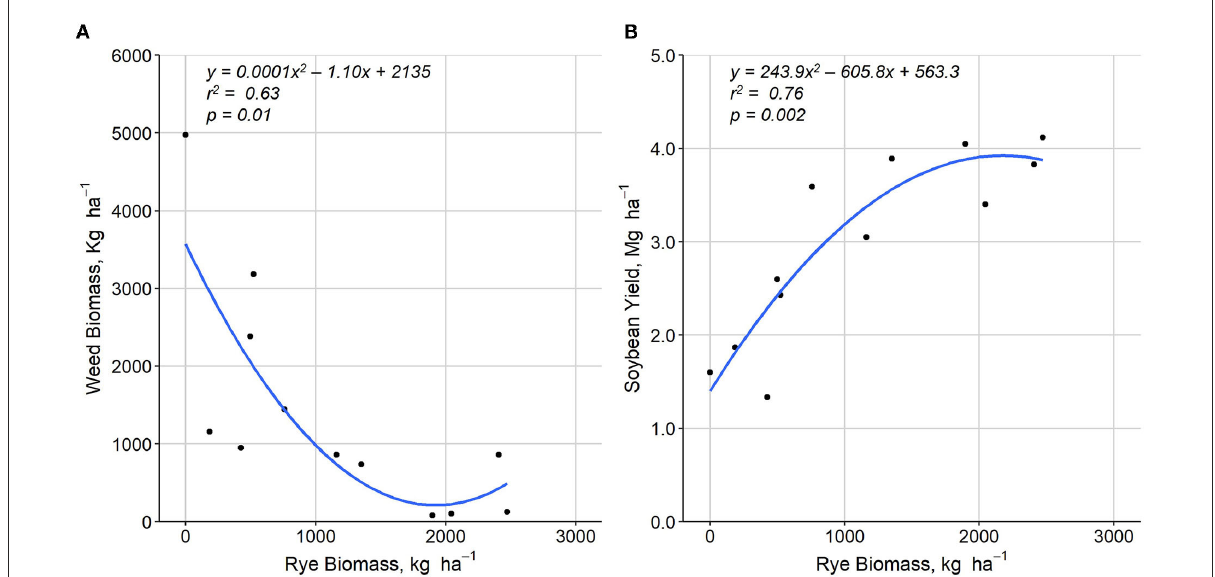
FIGURE4 Effects of winter rye biomass on (A) weed biomass and (B) soybean yield measured at the Arlington Agricultural Research Station in Arlington, WI and the Michael Fields Agricultural Institute, East Troy, WI,